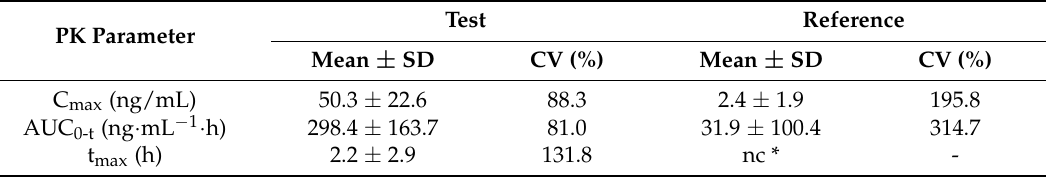
Table 3. Pharmacokinetic parameters of diosmetin after oral administration of micronized diosmin (T and